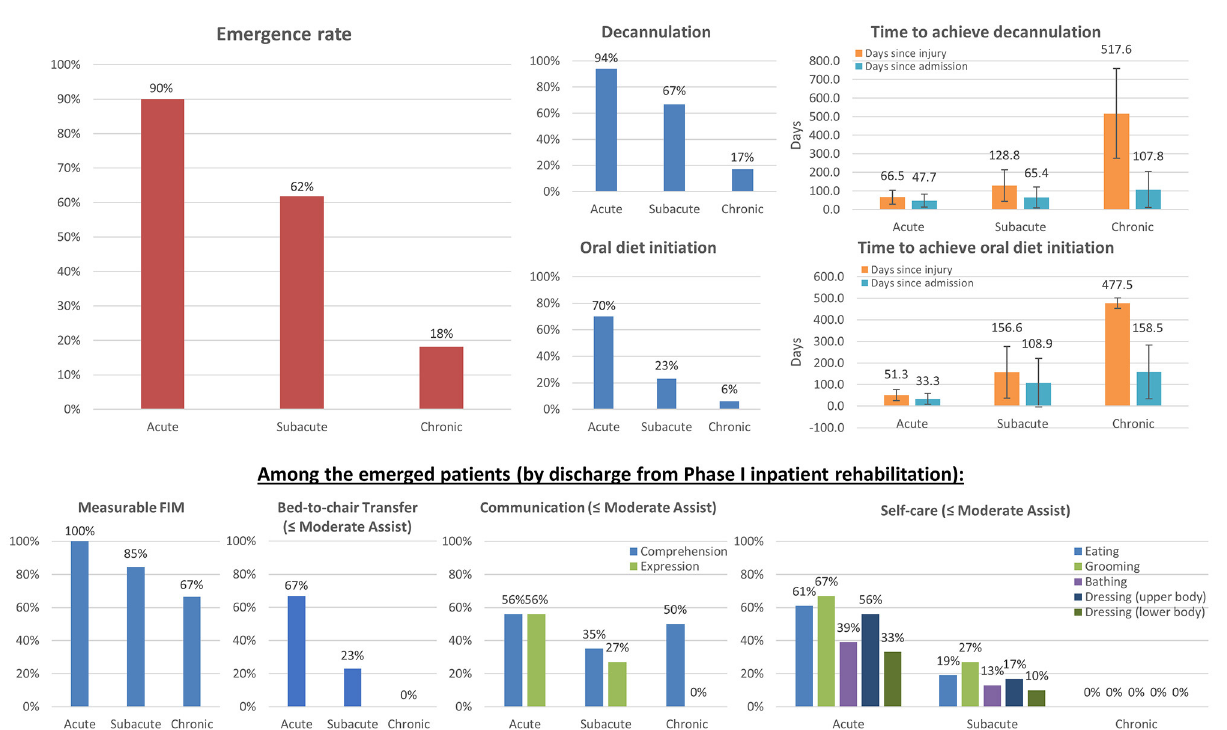
FIGURE1 Functional recovery among patients with DoC admitted at different stages post-injury. The total numbers of patients included at the acute, subacute, and chronic stages were 20, 84, and 33, respectively. The left upper panel shows the overall emergence rates (N = 18, 52, and 6, respectively). The four right upper panels show the overall decannulation and oral diet initiation rates and corresponding time to those achievements after injury and after admission. The four bottom panels show the percentages of patients undergoing meaningful improvements in transfer, communication, and self-care among emerged patients, requiring only moderate assistance or less (by the end of Phase I inpatient rehabilitation). The results demonstrate that specialized intensive inpatient rehabilitation is crucial for functional recovery from DoC with measurable and meaningful